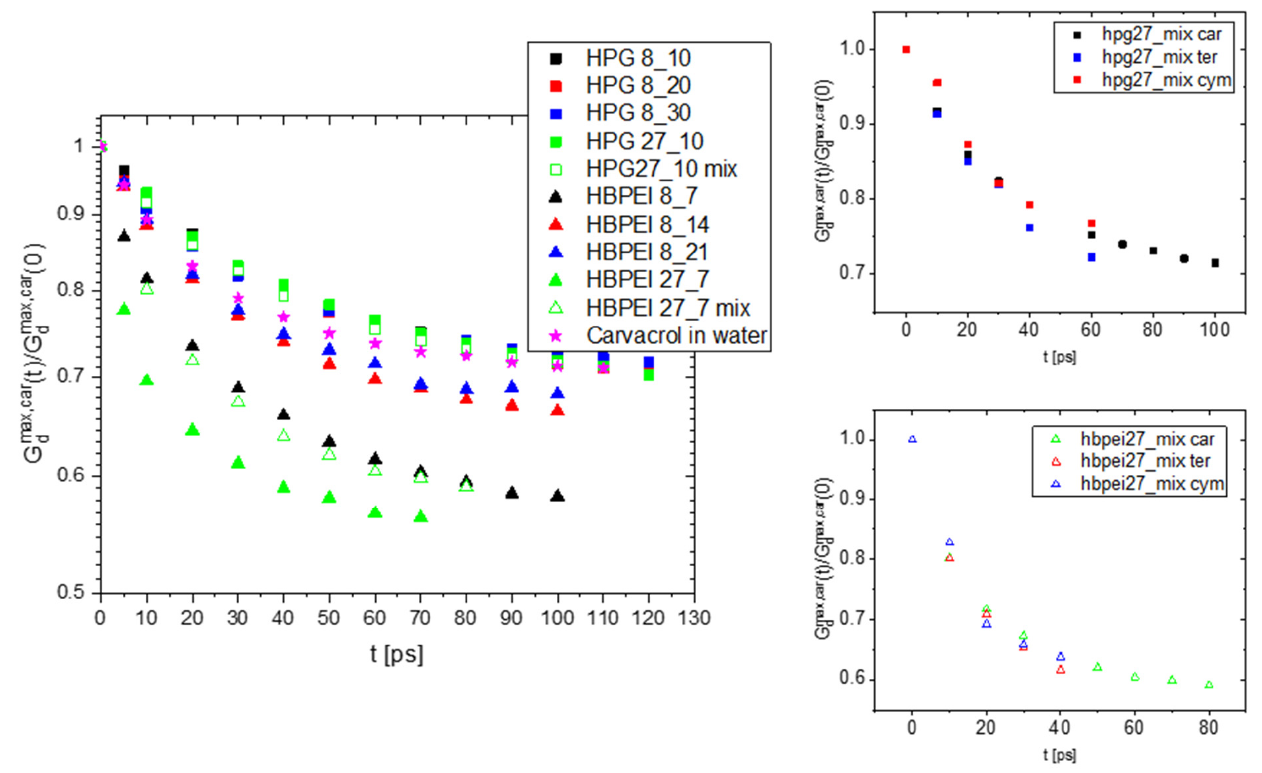
Figure 7. Left: Maxima of distinct van Hove functions relative to corresponding values at t = 0 for carvacrol in HPG- and HBPEI-containing systems for all concentrations and system sizes studied; data for carvacrol aquatic solution are also included. Right: Distinct van Hove functions for γ -terpinene and p-cymene compared with carvacrol in HPG (top) and HBPEI (bottom) systems. HBPEI systems, on the other hand, exhibit significantly faster decorrelation,